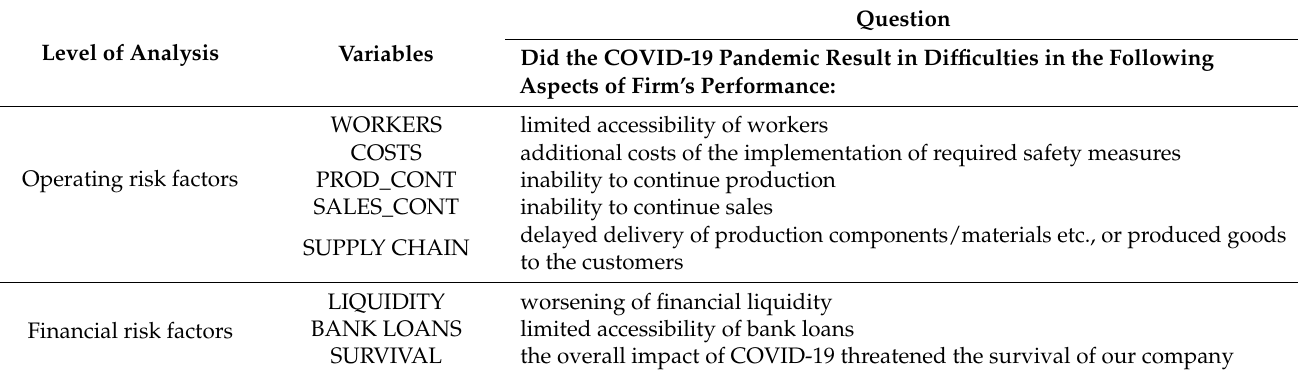
Table 1. Survey design: questions on COVID-19